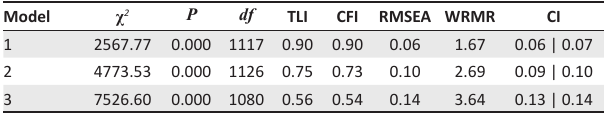
TABLE 2: Fit statistics for the three competing measurement models.